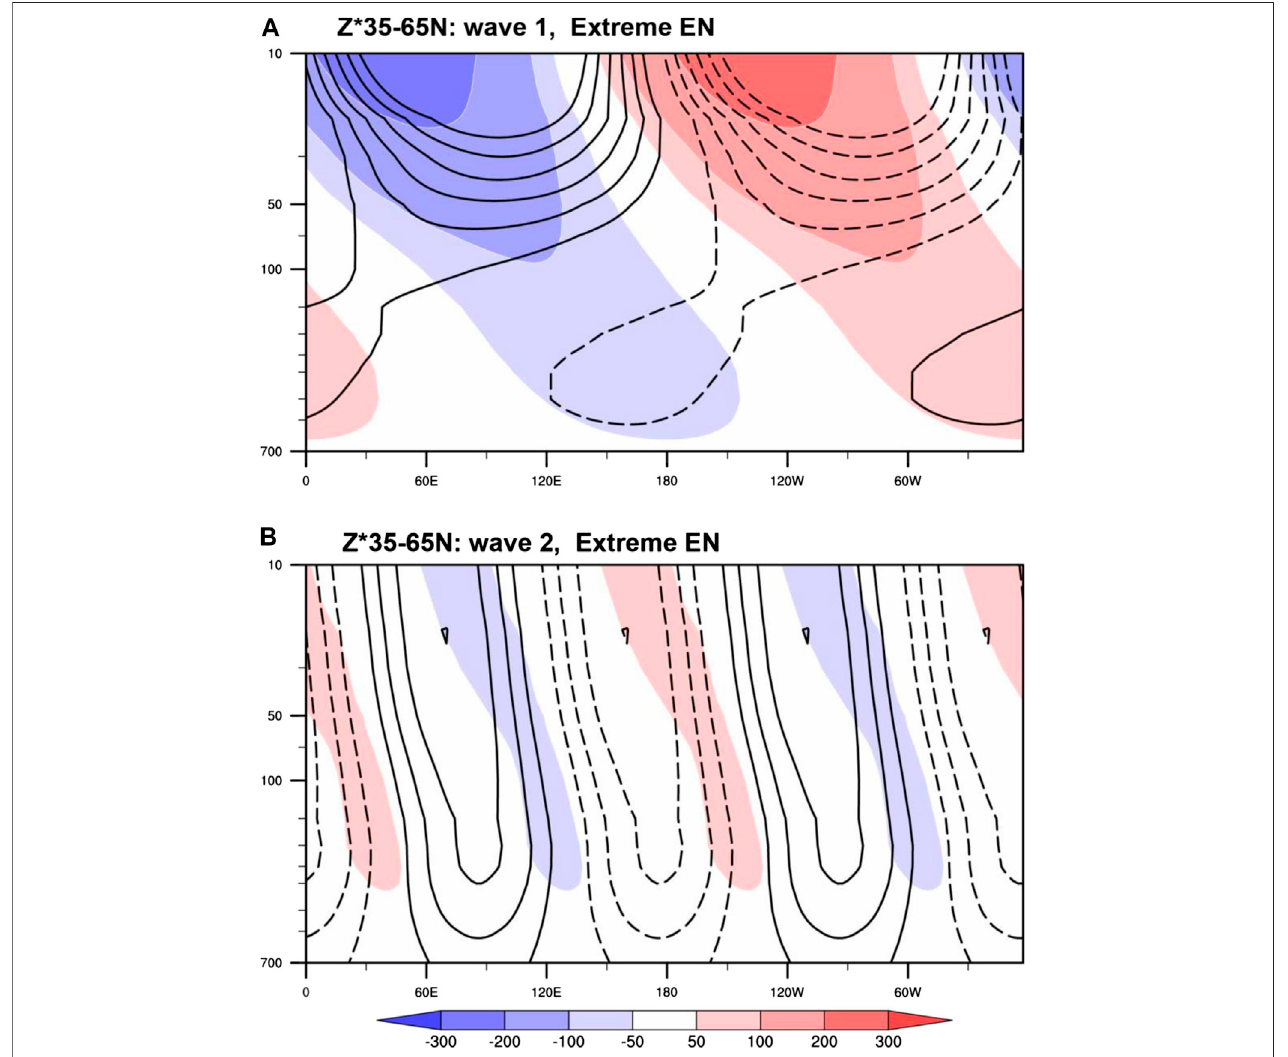
FIGURE 6 | Longitude – height cross-section of the zonally asymmetric component of geopotential height anomalies (Z*) associated with stationary waves of (A) wavenumber 1and (B) wavenumber2,averaged over30 ° – 60 ° Nduringextreme EN.Contours indicate forcedwavesderivedassensitivityminuscontrolvalues(contour intervalsare20 m;negativecontoursaredashed),andshadingindicatestheclimatologicalstationarywave fi eldfromthecontrolexperiment.FigureforthemoderateEN case with no obvious response were omitted.